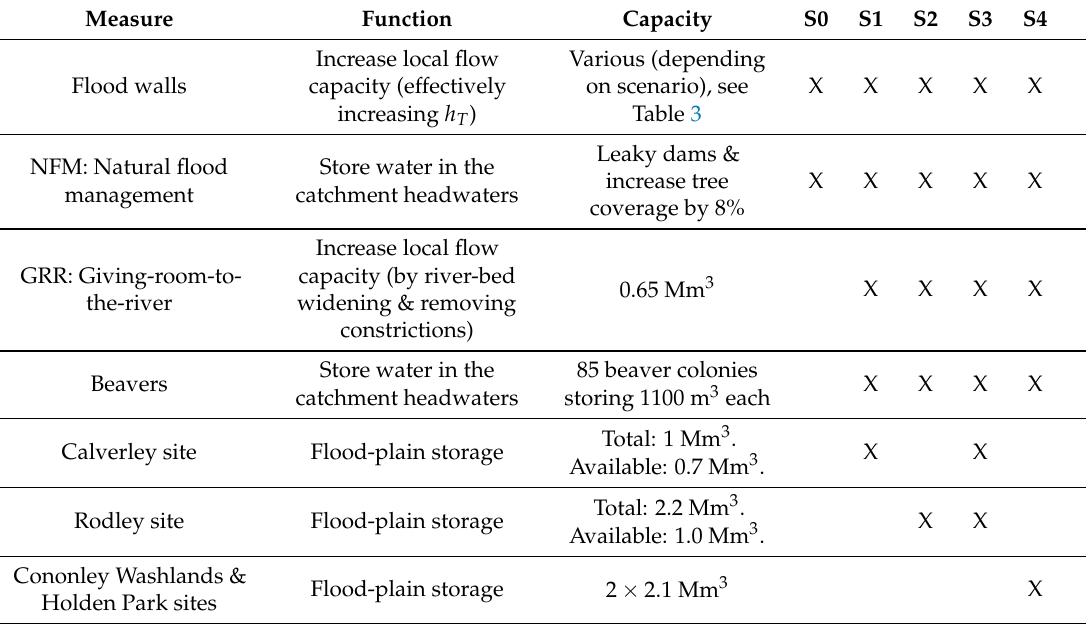
Table 2. Hypothetical flood-alleviation scheme FASII + : a summary of the various protection measures, their function (qualitative) and capacity (quantitative), and in which scenarios (S0–S4) they feature. A detailed description of each component is given in Sections